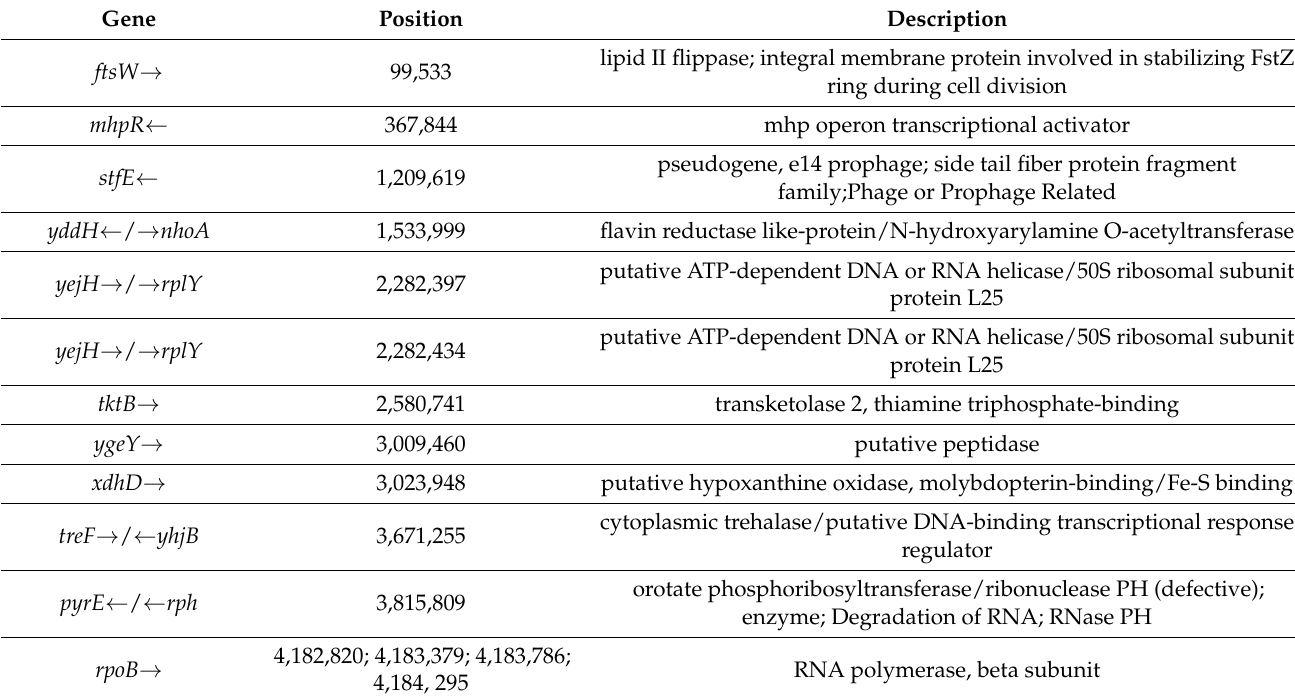
Table A5. Position and description of significant polymorphisms, control populations, day 28.